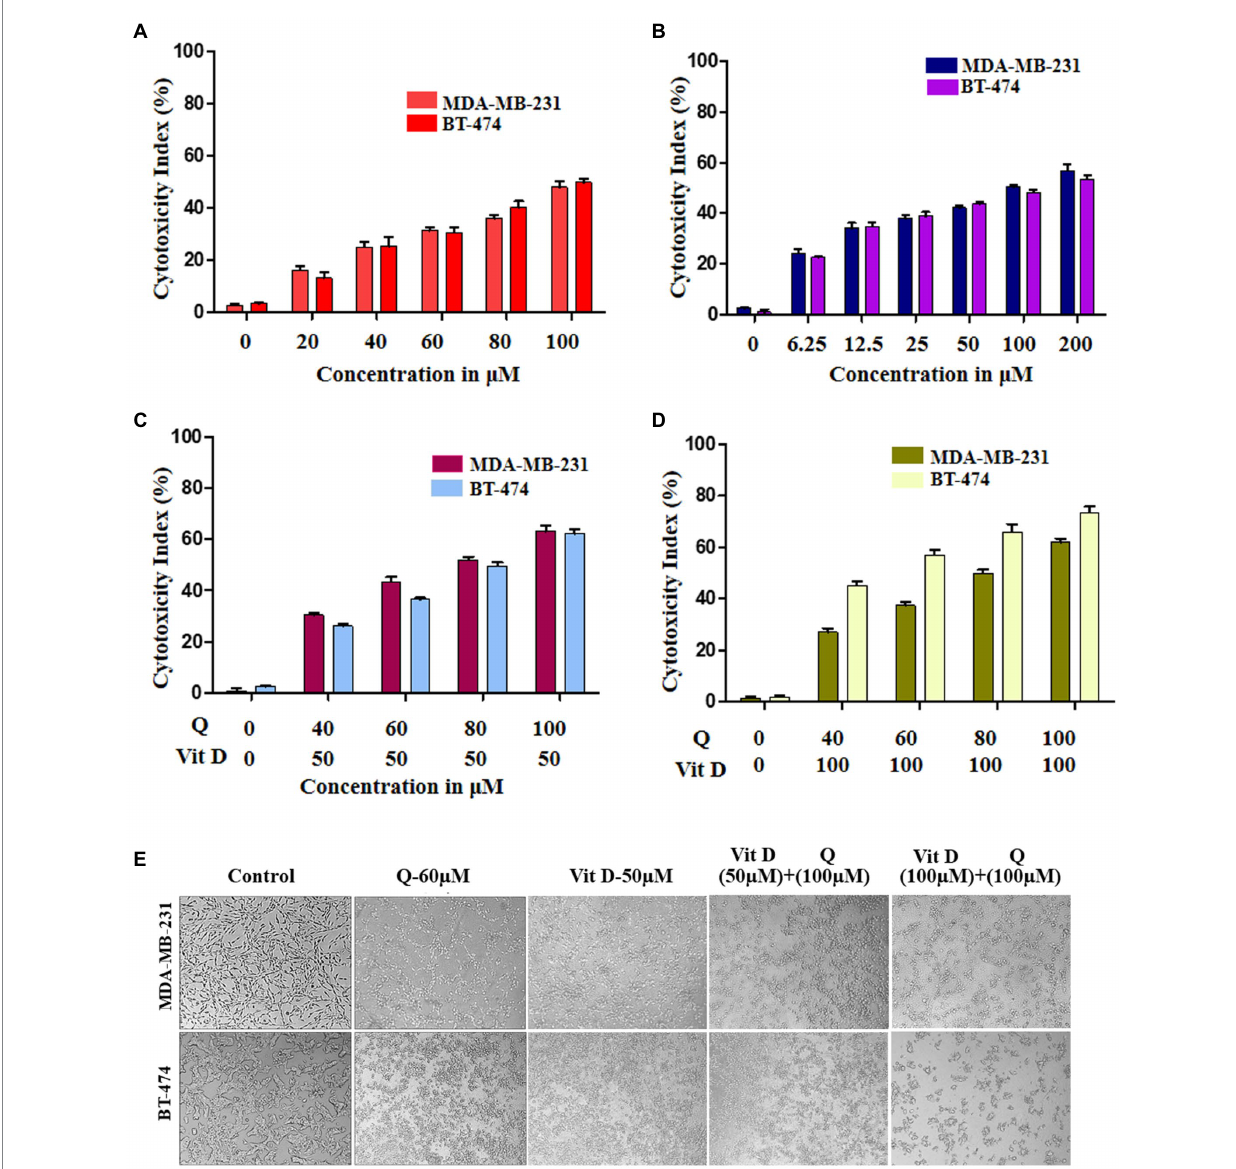
FIGURE 5 Cytotoxicity effect of quercetin and vitamin D3 on breast cancer cell lines. (A–D) Cell death was induced in human breast cancer cell lines (MDA- MB-231 and BT-474) by quercetin, vitamin D3 and combination of both in dose dependent manner for 24 h ( n = 3). (E) Photograph representing the cytotoxicity effect of quercetin, vitamin D3 and combination for 24 h in respective dosage ( n =